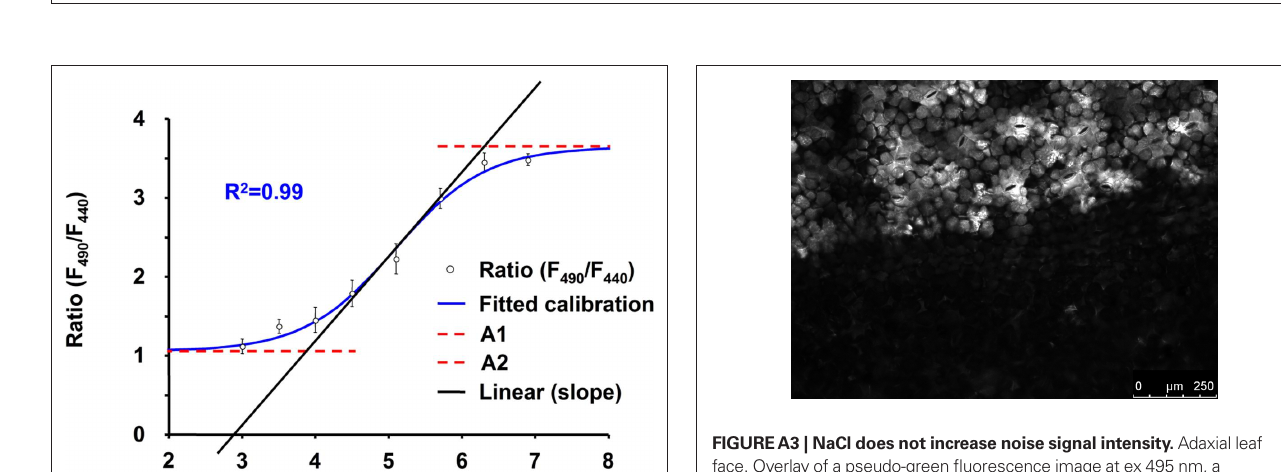
(compare with Figure 2 ). Images were taken immediately after the dye was loaded (A) , 2 min after loading (B) and (C) 15 min after loading. This time series demonstrates that the water exits the leaf through the stomata after at least 15 min.